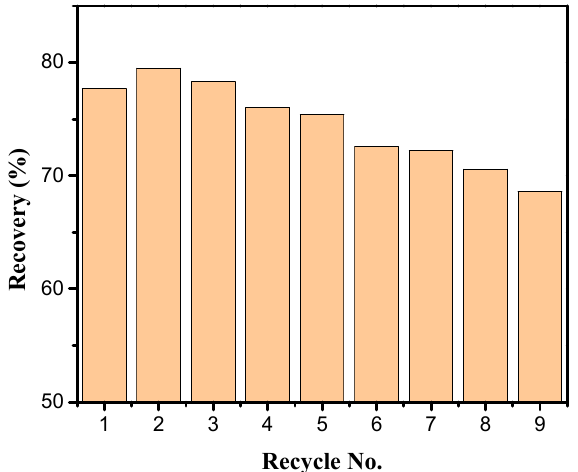
Figure 11. Recycling performance of the MIPMs when used as the stationary phase of the MISPE column for processing of clenbuterol solution through the evaluation of the spike recovery for each